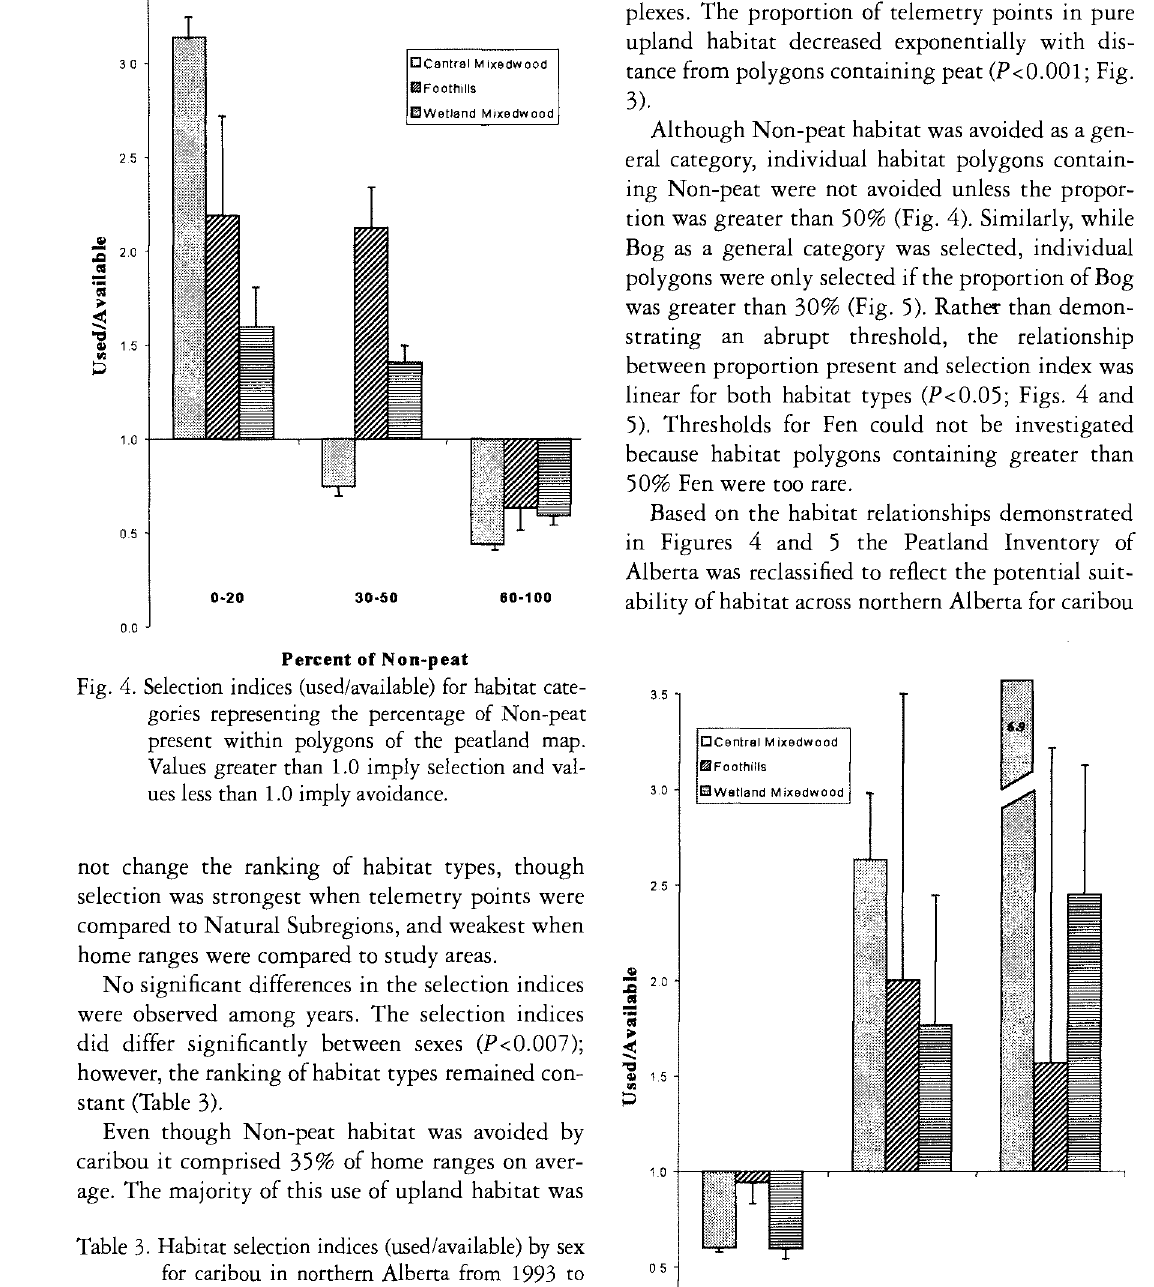
Table 3. Habitat selection indices (used/available) by sex for caribou in northern Alberta from 1993 to 1998.